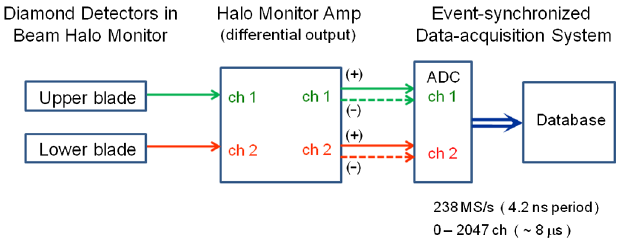
FIG. 18. Schematic diagram of the beam halo monitoring system.